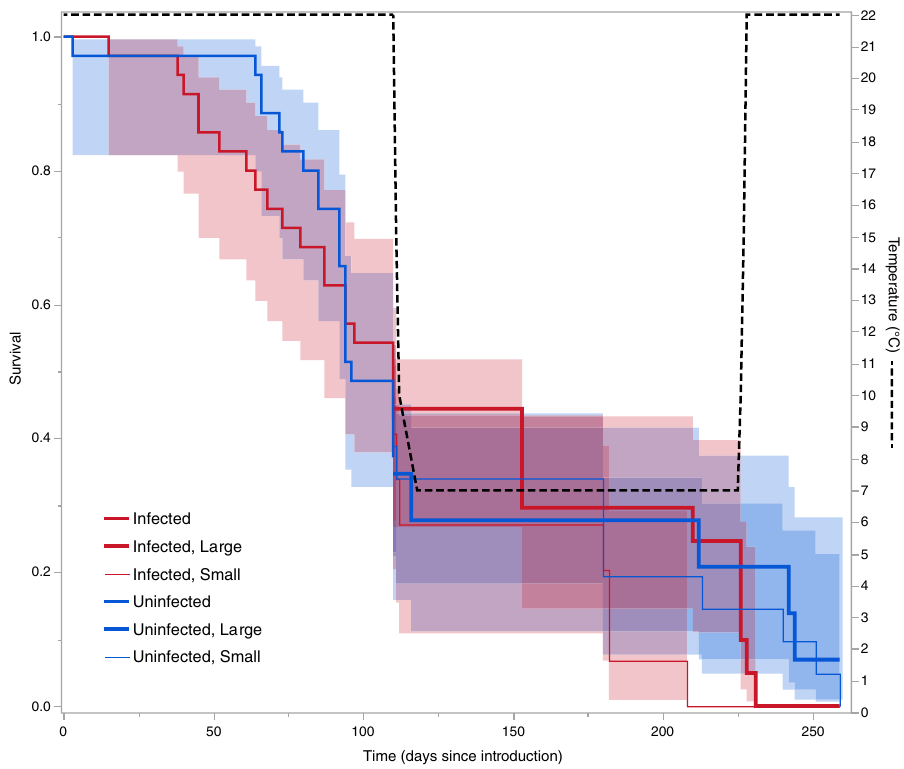
Figure 4. Survival of caterpillars in the mini colonies, and temperature at which they were kept. Before overwintering (drop in temperature after 110 days), nests are divided into those that were infected by Rickia wasmannii and uninfected nests. All surviving caterpillars were weighed at the start of overwintering, and the survivorship of those above (Large) and below (Small) the mean mass in infected and uninfected nests are then shown separately. Shaded regions are 95% confidence intervals around the survivorship, estimated from a proportional hazards survival